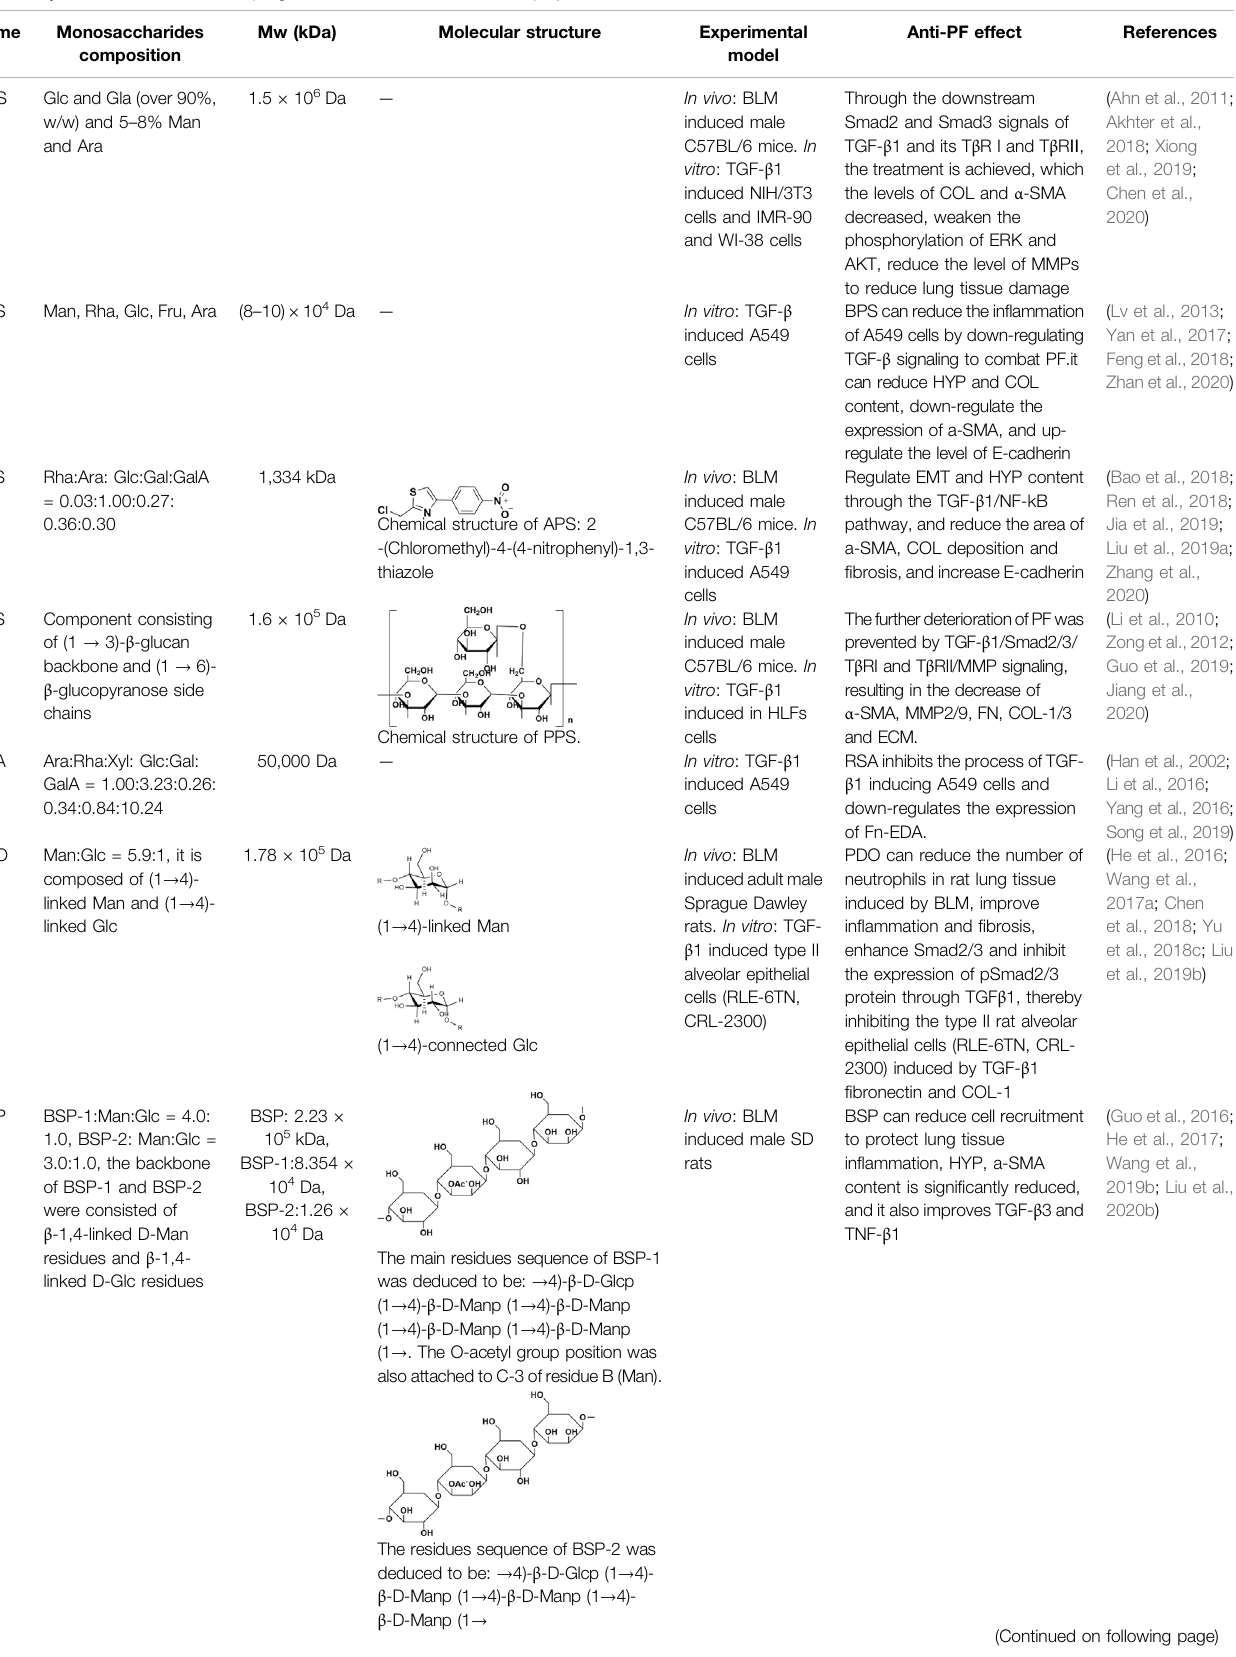
TABLE 1 | Overview of the research progress of Chinese herbal medicine polysaccharides in the treatment of PF.